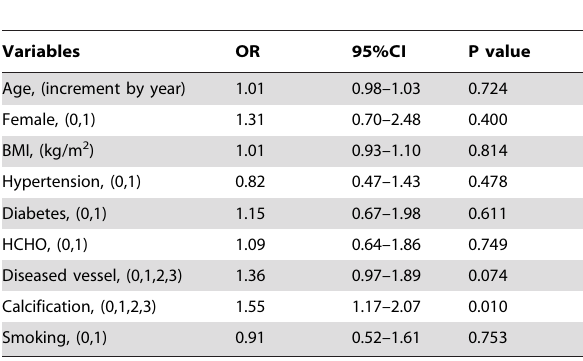
Table 7. Contribution of baseline variables to PMI in the final logistic regression